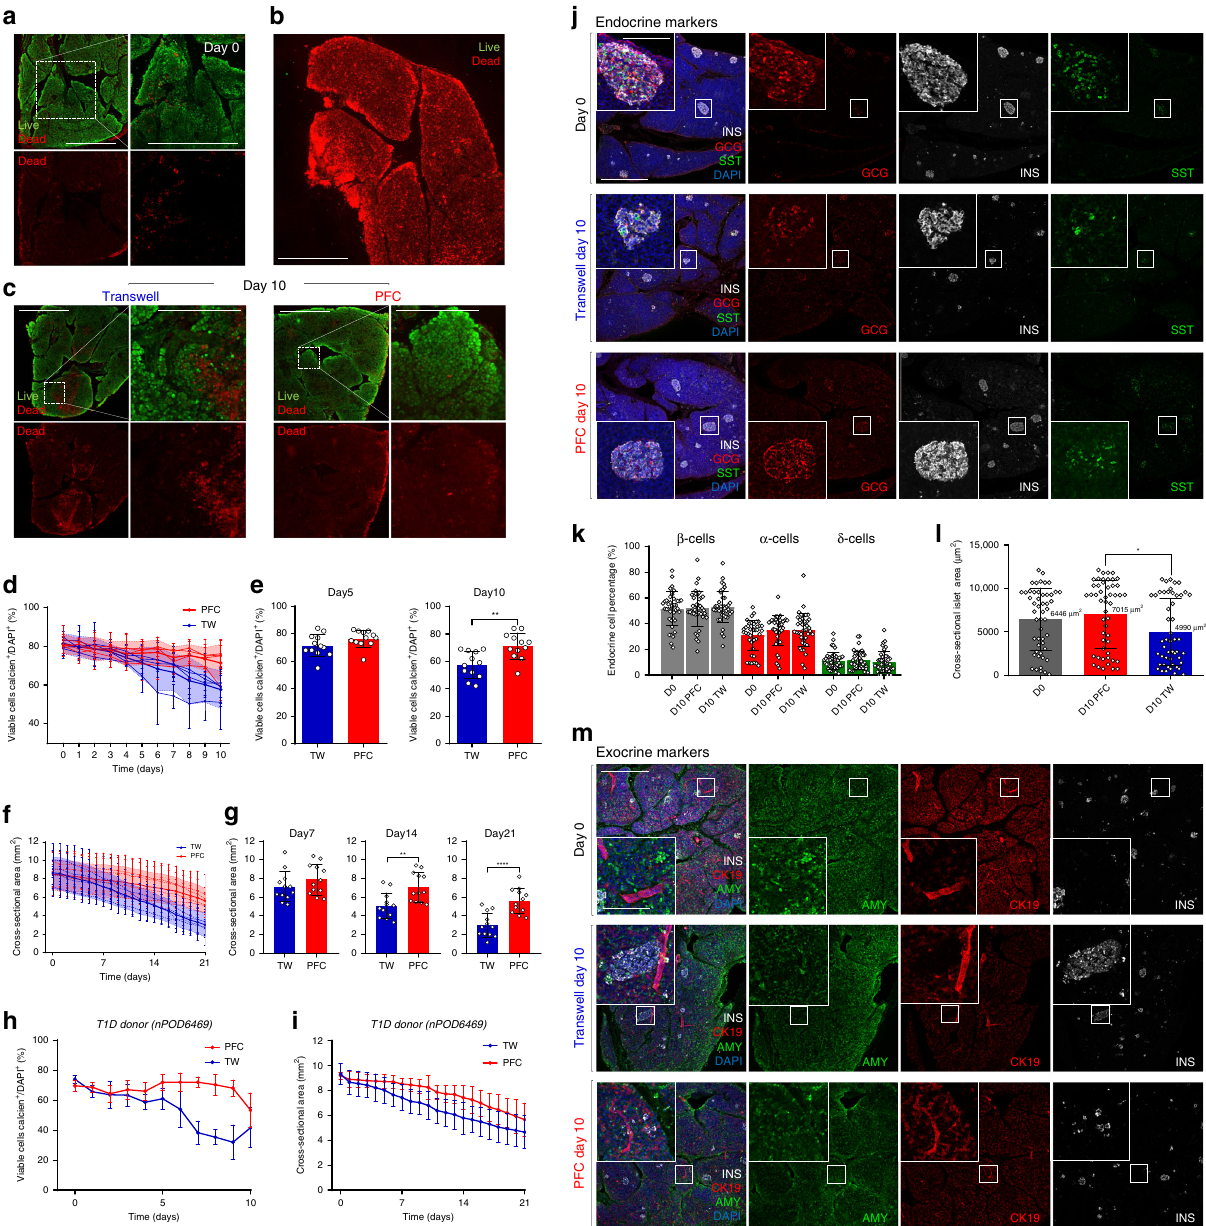
Fig. 2 Human pancreatic slices remain viable after extended culture. a Representative immunostaining showing tissue viability at the time of tissue slicing, showing live (green) and dead (red) regions. Scale: 500 µ m for all panels. b Immunostaining of control fi xed slice showing only dead cells. Scale: 500 µ m. c Immunostaining showing slice viability assessments after 10 days of culture in either transwells or PFC dishes. Necrotic zones in transwell-cultured slices are highlighted in magni fi ed panel. Overt necrosis, in contrast, is not apparent in PFC-cultured HPSs. Scale: 500 µ m. Magni fi ed insets: 200 µ m. For a – c : n = 5 biologically independent samples from individual donors. d Quantitative measurement of viable cell percentages in PFC (red)- and transwell (blue)-cultured slices over a period of 10 days. Shaded area shows mean±SD. e Bar plots showing cellular viability of either culture setting at day 5 and 10 post-slicing. Two- tailed t -test: ** p -val 10days = 0.002. f Slice cross-sectional area of slices kept in either culture condition for 10 days in culture. Shaded area shows mean±SD. g Individual bar plots showing slice cross-sectional area at days 7, 14, and 21 post slicing. Two-tailed t -test: ** p -val 14days = 0.0036, **** p -val 21days = 0.000087. For d – g : n = 4 biologically independent samples from individual donors. h Viable cell percentages of PFC- and transwell-cultured T1D donor slices over a period of 10 days ( n = 1 sample from an individual donor). i Slice cross-sectional area in either culture condition over 10 days of culture (T1D donor) ( n = 1 sample from an individual donor). j Immuno fl uorescence images showing expression of representative endocrine markers (INS insulin, white; GCG glucagon, red; and SST somatostatin, green) within islets of slices at day 0 and cultured for 10 days in either transwells or PFC dishes. Scale for all panels: 500 µ m; 100 µ m for insets. k Dot plot showing the distribution of endocrine cells in islets at day 0 and after 10 days of culture (PFC and transwells). l Dot plot showing the cross-sectional area of islets at day 0 and after 10 days of culture (PFC and transwells). Two-tailed t -test: * p -val D10 (PFC)-D10 (TW) = 0.0107. For j – l : data from n = 10 biologically independent samples from individual donors. m Immunostaining showing insulin (INS, white) and representative exocrine markers (cytokeratin-19, CK-19, red; and amylase, AMY, green) within slices at day 0 and after 10 days of culture (PFC and transwells). Blue, DAPI counter-staining. n = 10 biologically independent samples from individual donors. Scale: 500 µ m; 100 µ m for insets. For d – i , k , and l , data are presented as mean±SD. Each n further represents the mean of three technical replicates. * p <0.05; ** p <0.01; *** p <0.005. Source are provided in the Source Data fi